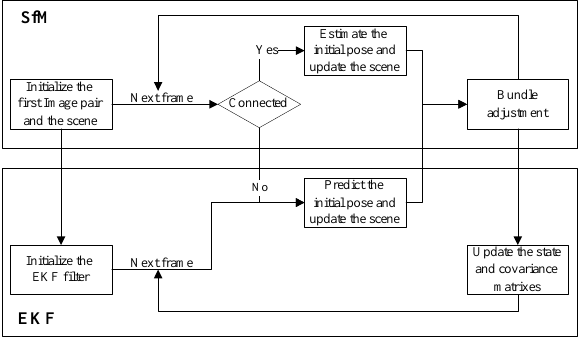
Figure 1. Pipeline of the SfM algorithm with an EKF filter